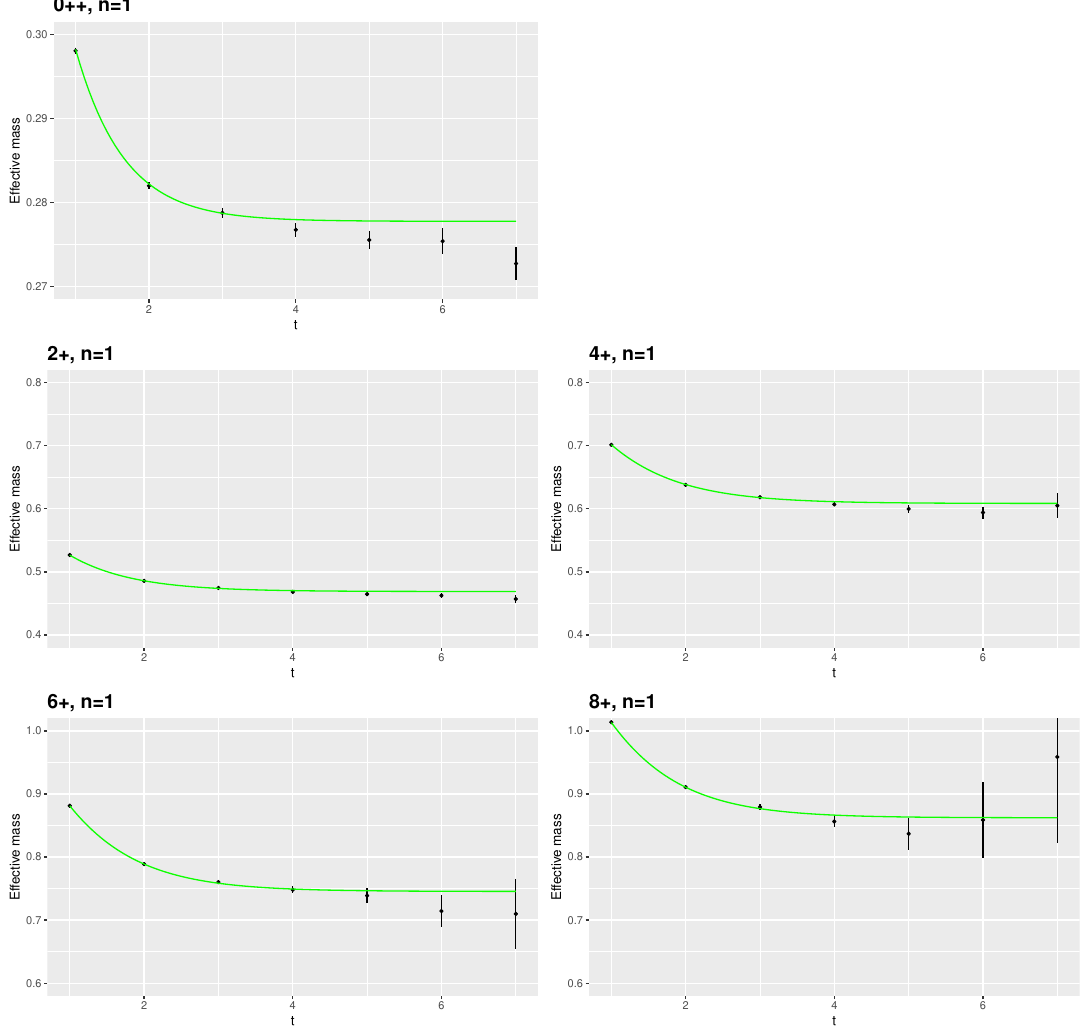
Figure 8. Plot of e(cid:11)ective mass E e(cid:11) ( t ) versus t (with (cid:12)t, green curve) for leading Regge trajectory states, 0 ++ , J C = 2 + ; 4 + ; 6 + ; 8 + . Note vertical scales di(cid:11)er between